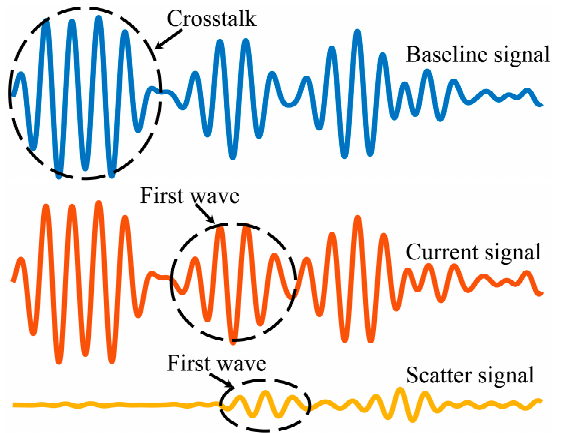
Figure 3. Lamb wave signals.